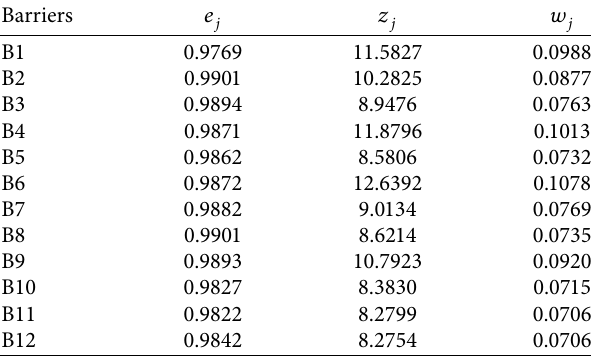
Table 8: Priority weights of the barriers to EDUC4